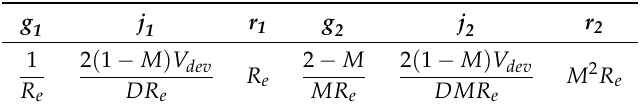
Table 4. Parameters of the small-signal DCM model for the buck converter.